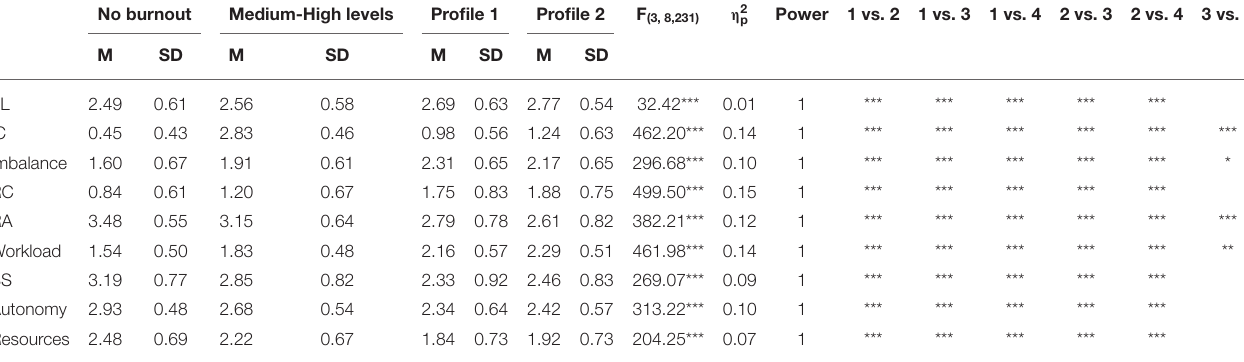
TABLE 1 | ANOVA between profiles and